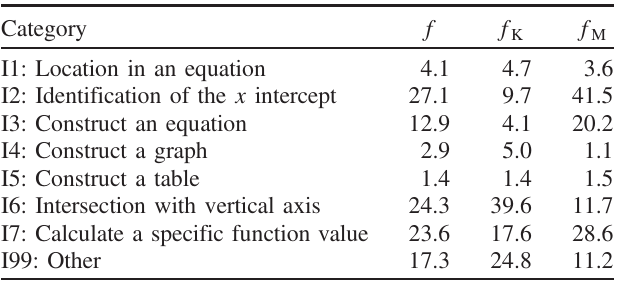
TABLE IV. Frequencies (in %) for the y intercept questions. f is across both contexts, f is in the kinematics context and f K in the mathematics context. The percentages are relative to 1600, 723, and 877, respectively.